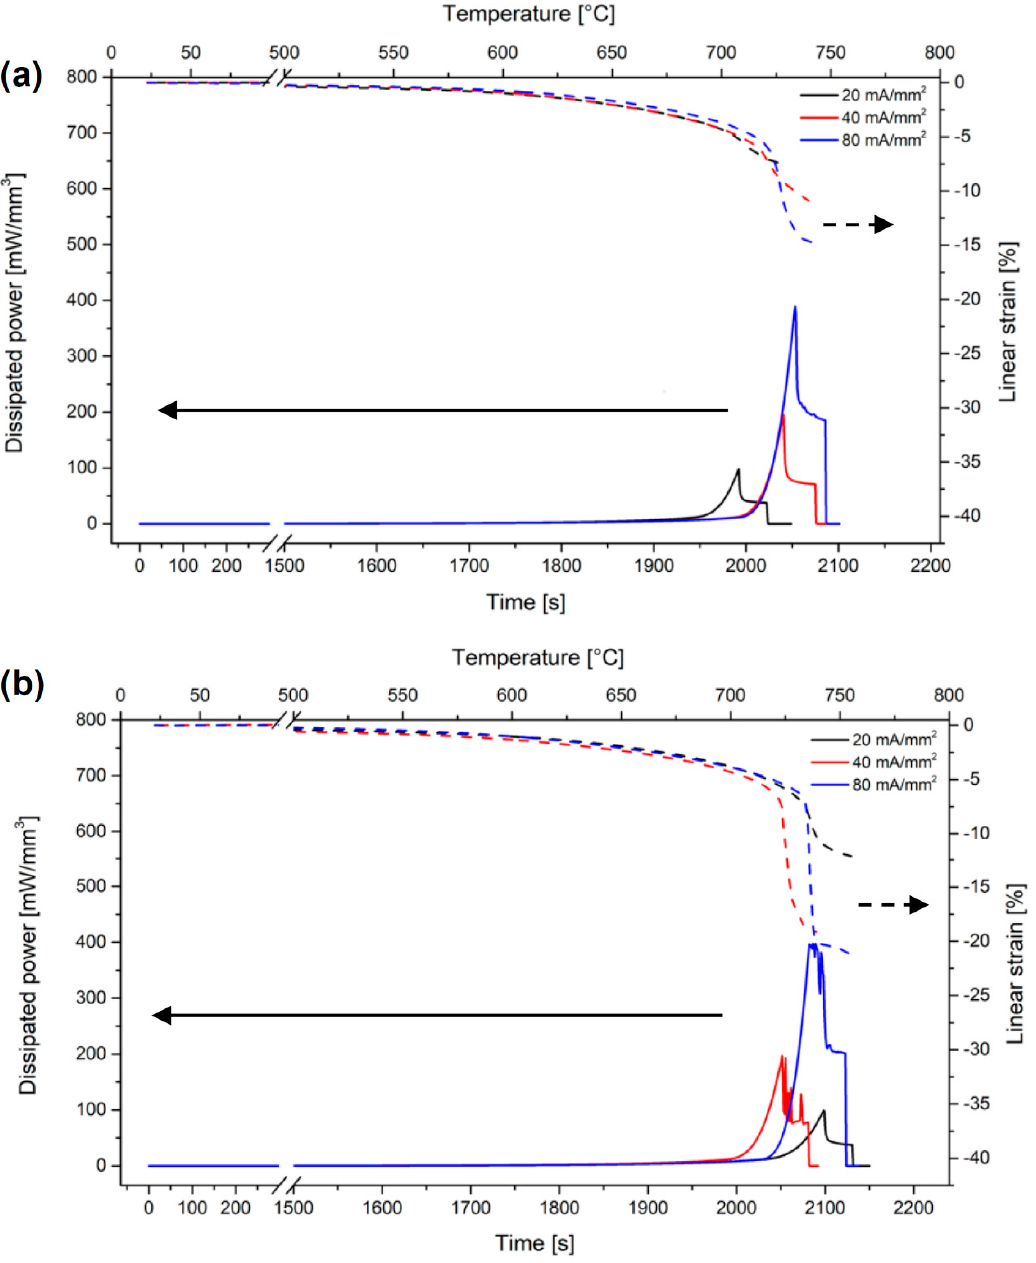
Figure 4. Specific power density and deformation for SPDC-AC ( a ) and GPDC-AC ( b ) samples sintered under 50 V/cm and with different current limits.